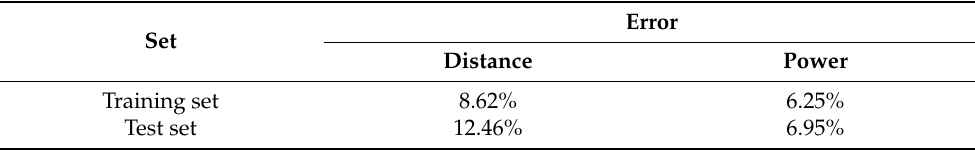
Table 4. Errors of consequence prediction